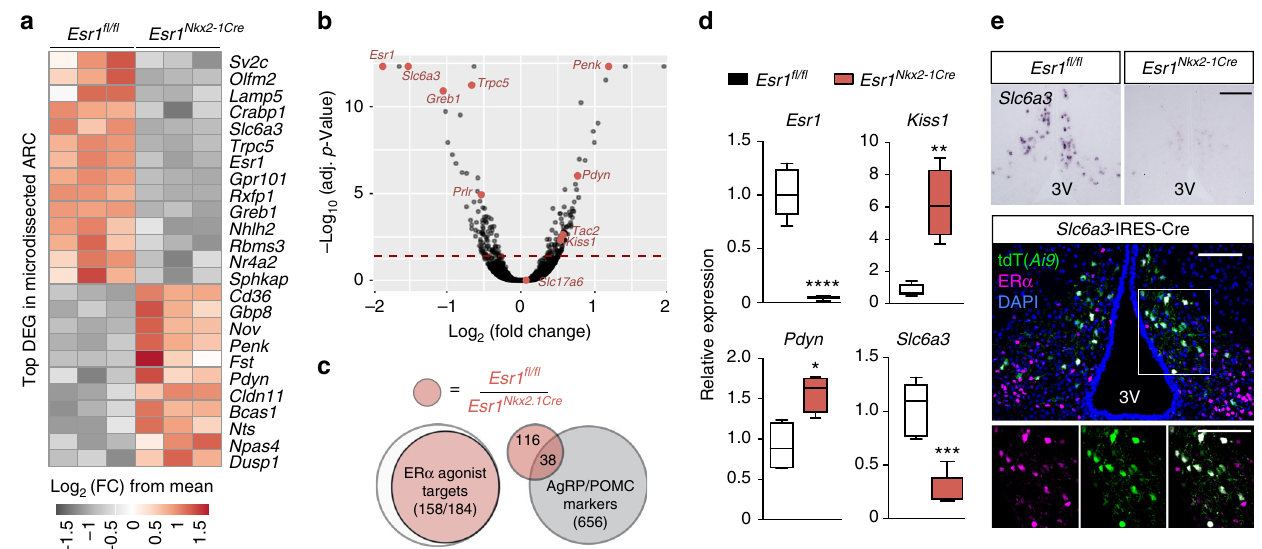
Fig. 5 Bone formation correlates with changes in KNDy and DAT ARC neurons. a Heat map of top 25 most signi fi cant DEGs in ARC of Esr1 fl / fl ( n = 3) and Esr1 Nkx2.1Cre females ( n = 3) (15 weeks). b Volcano plot of data set with highlighted genes (red). Dashed red line represents signi fi cance cutoff with adjusted p value < 0.05). c Overlap of DEGs with adjusted p value < 0.05 and |log2 fold change| > 0.6 between ARC from Esr1 fl / fl and Esr1 Nkx2.1Cre mice (red) with identi fi ed ER α agonist-responsive transcripts (white) 61,62 and with identi fi ed markers of AgRP and POMC neurons (grey) 63 . d Expression of Esr1 , Kiss1 , Pdyn , and Slc6a3 measured by qPCR ( n = 4 – 6 per genotype with controls as open boxes and Esr1 Nkx2.1Cre females as red boxes; (center line = median; bounds are minimum to maximum). e Representative ISH of Slc6a3 in ARC and confocal image of ARC co-labeled with Slc6a3 reporter ( Ai9 , tdT), ER α and DAPI. Image scale bars for top and bottom panels = 100 µ m. Student ’ s unpaired t test ( d ). Error bars are ±SEM. * p < 0.05; ** p < 0.01; *** p < 0.001; **** p <